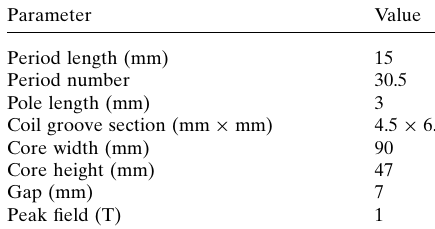
Table 1 Parameters of the SCU simulation model.